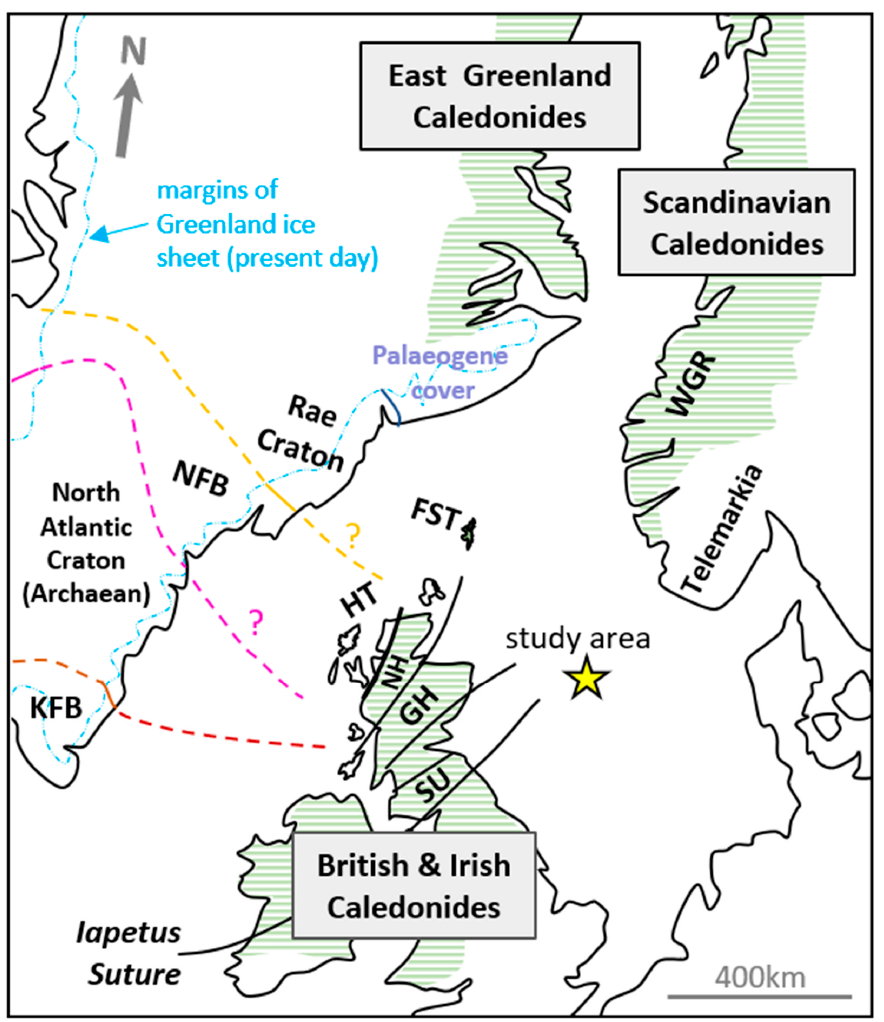
Figure 6. Generalised pre-Atlantic drift map reconstruction of the North Atlantic region showing the extent of the Caledonide orogenic belt (dashed green fill), and the location of terranes discussed within the main text. Abbreviations: FST, Faroe-Shetland Terrane; GH, Grampian Highland Terrane; HT, Hebridean Terrane; KFB, Ketilidian Fold Belt; NH, Northern Highland Terrane; NFB, Nagssugtoqidian Fold Belt; SU, Southern Uplands Terrane; WGR, Western Gneiss Region. Based on Dawes [107], Holdsworth et al. [97], and Kinny et al. [96].